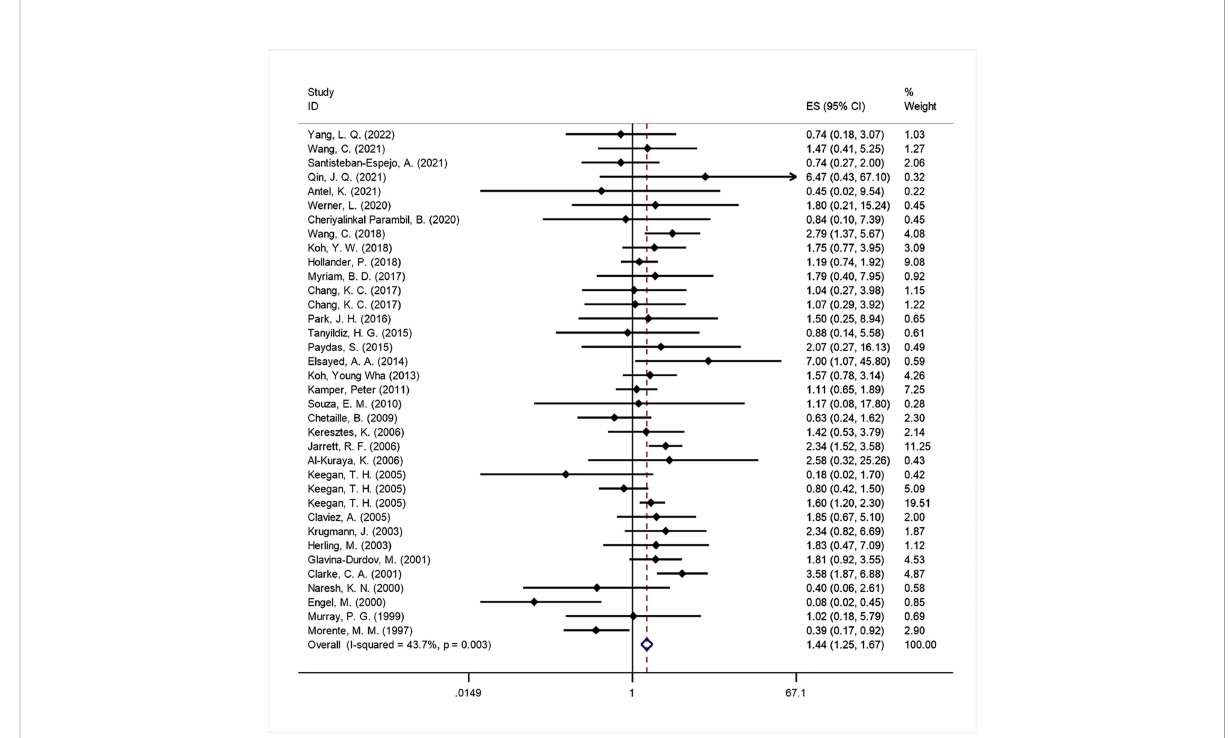
FIGURE 2 Forest plot of the hazard rations for overall survival (OS) between patients with EBV-positive and EBV-negative